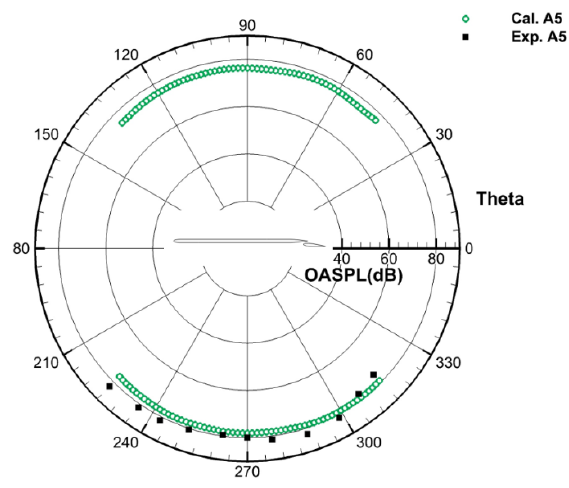
Figure 11. Sound pressure levels of far field probes.